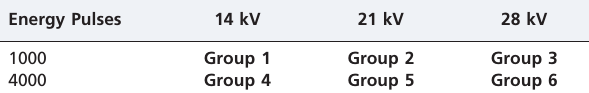
Table 1 - Distribution of groups in terms of energy level in kilovolts (kV) and the number of pulses